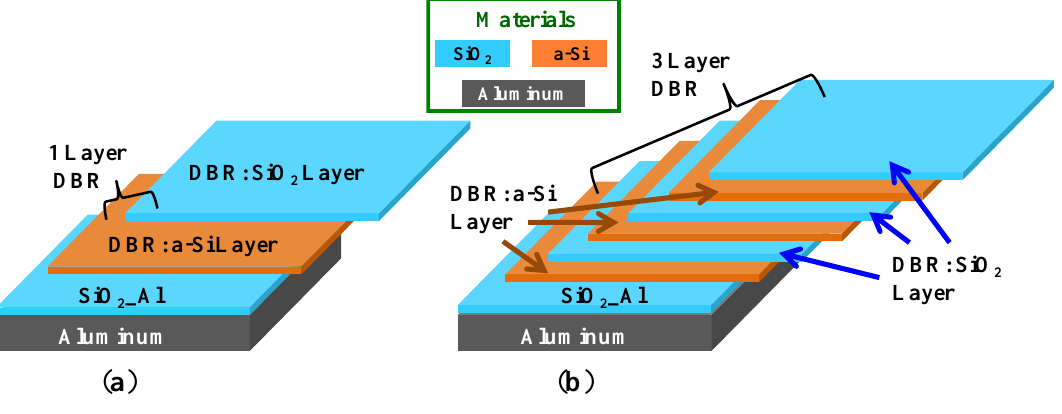
Figure 6. Design schematic of the, (a) 1 Layer DBR and, (b) 3 Layer DBR structures. The SiO (DBR:SiO Layer) and a-Si (DBR:a-Si Layer) layers of the DBR structures are 2 2 labeled. The phase matching SiO layer (SiO _Al) and the aluminum layer are also shown. 2 2